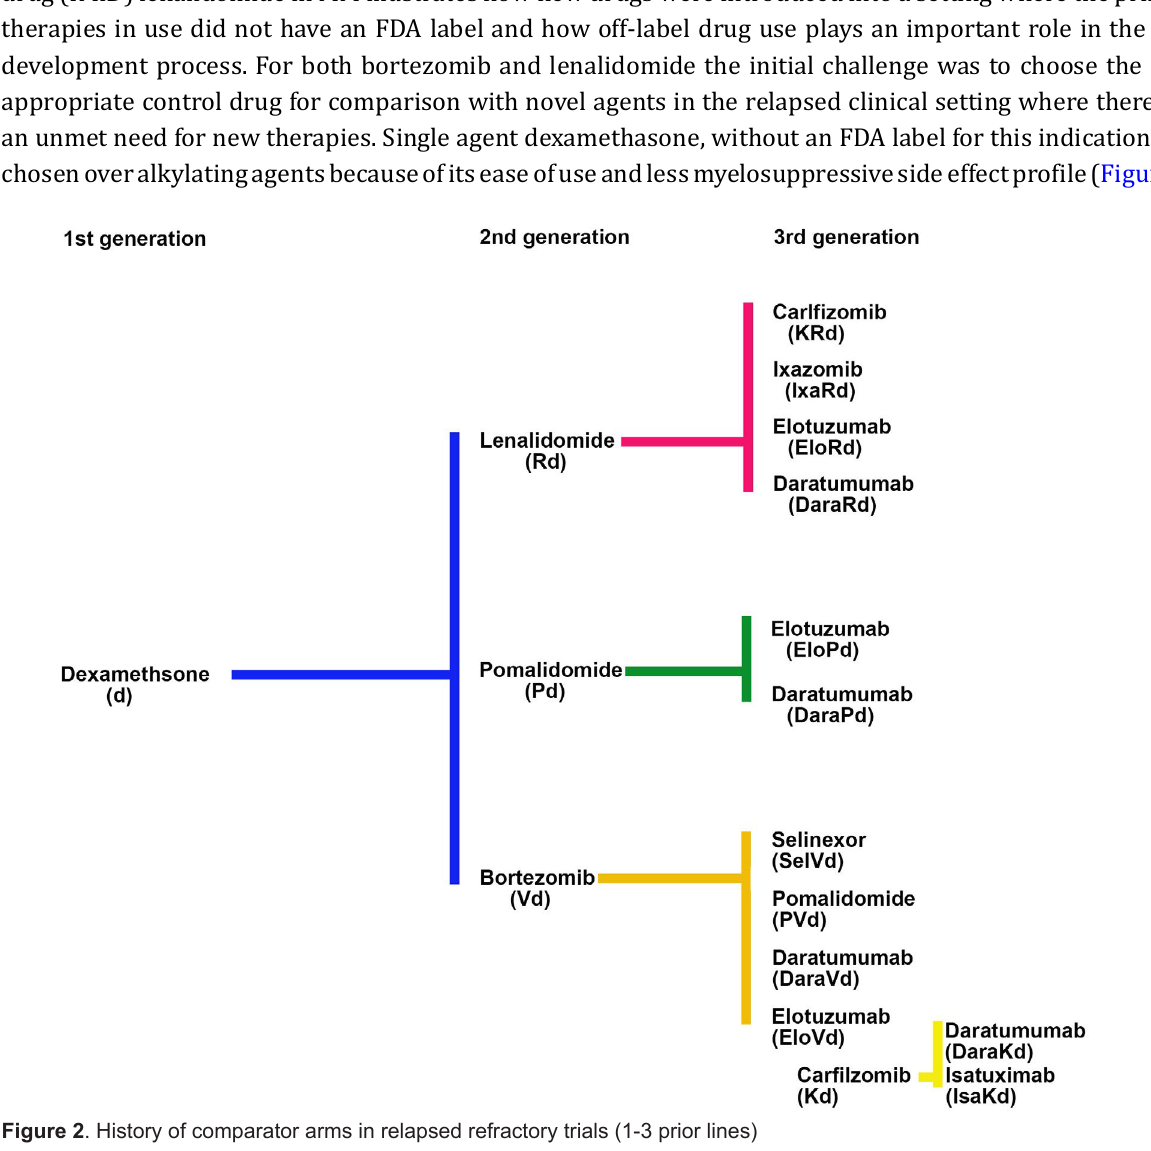
Explor Target Antitumor Ther. 2021;2:355-73 | https://doi.org/10.37349/etat.2021.00050